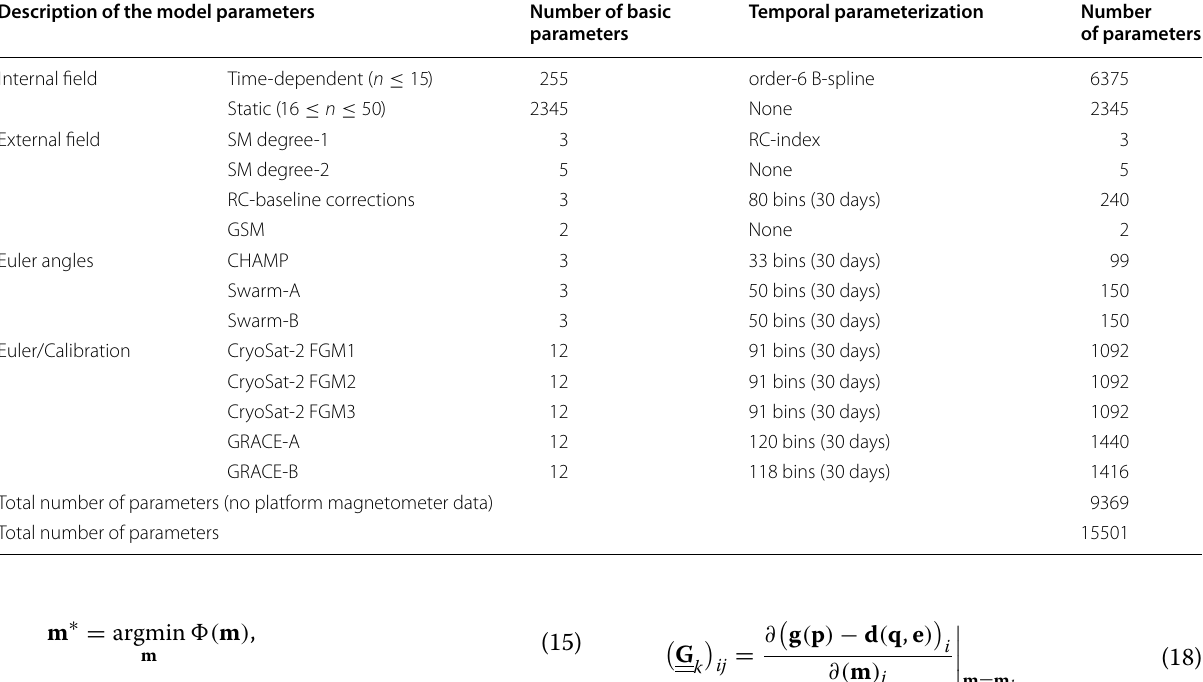
Table 1 Details on the parameterization of the individual model parts. Here, the number of basic parameters refers to the number of parameters irrespective of an explicit time-dependence Description of the model